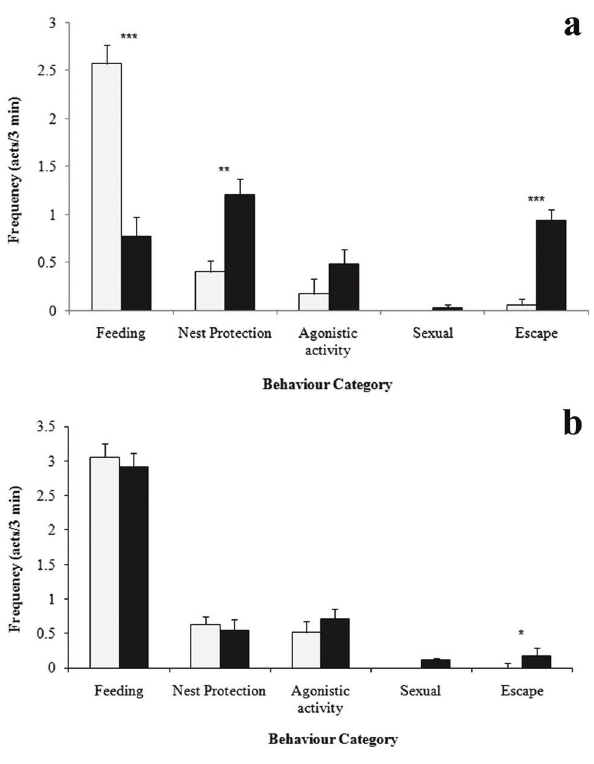
Fig. 6. Variation of behaviour patterns between before (8h00) and after (9h00) the first disturbance of tourists in the river (mean and SEM) for Crenicichla lepidota . (a) Tourism; (b) No Tourism. Lighter bars = 8h00; darker bars = 9h00 (Mann-Whit- ney U-test). N = 35; *p < 0.05; **p < 0.01;***p <